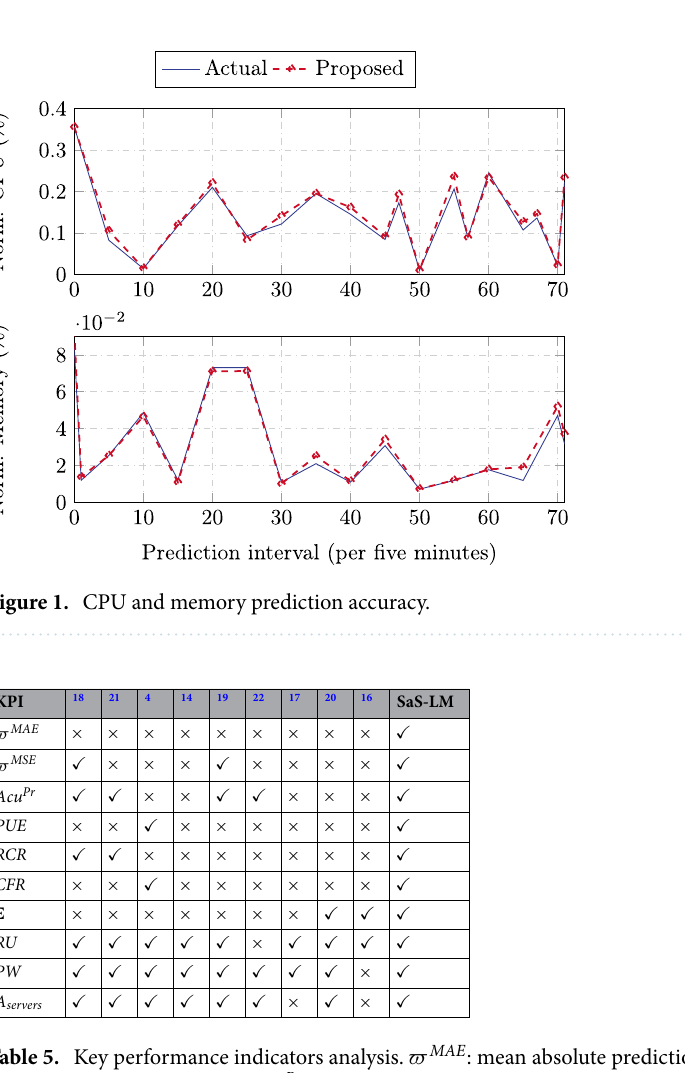
Table 5. Key performance indicators analysis. ̟